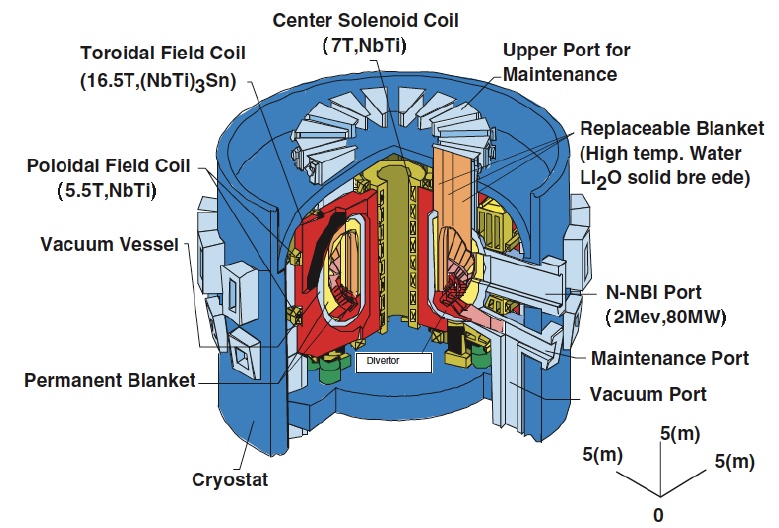
Figure 9. Bird’s eye view of SSTR(Steady State Tokamak Reactor) tokamak core [79].